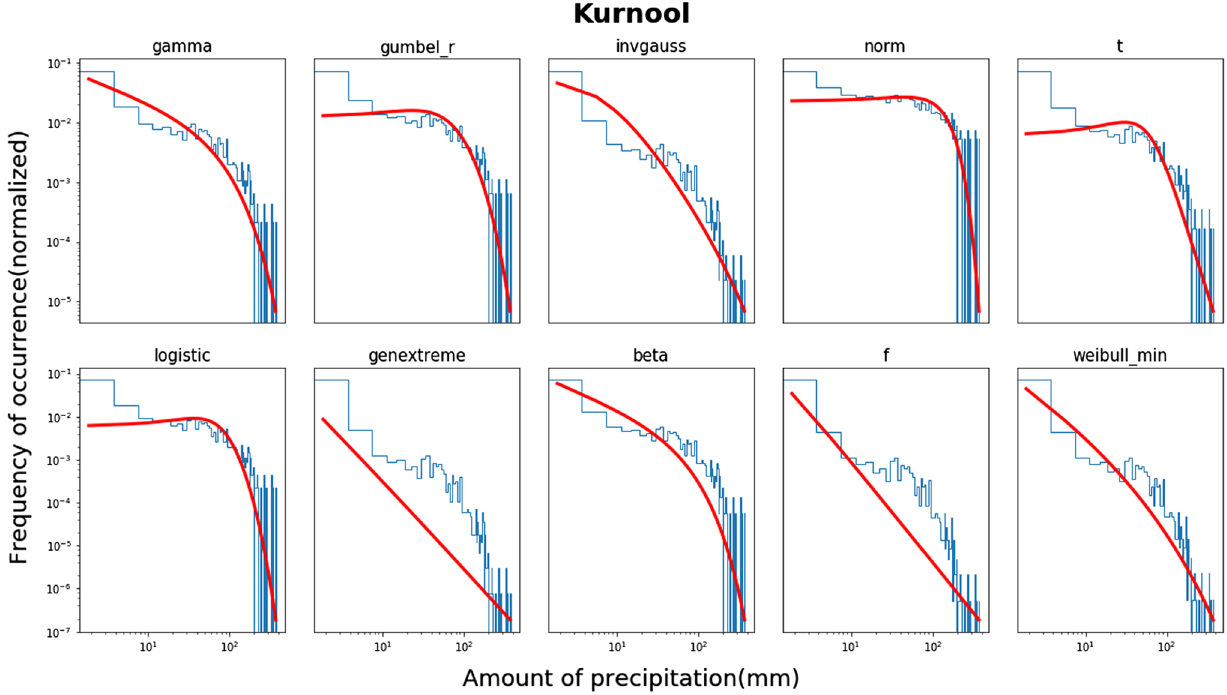
Fig. 2 Histogram of the monthly precipitate data at Kurnool (blue lines) along with best fit for each of the 10 probability distributions functions